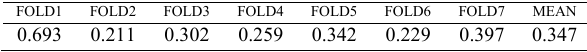
Table 13. RMS errors for the 7 folds (fuzzification parameters defined by the GA with variable MARK